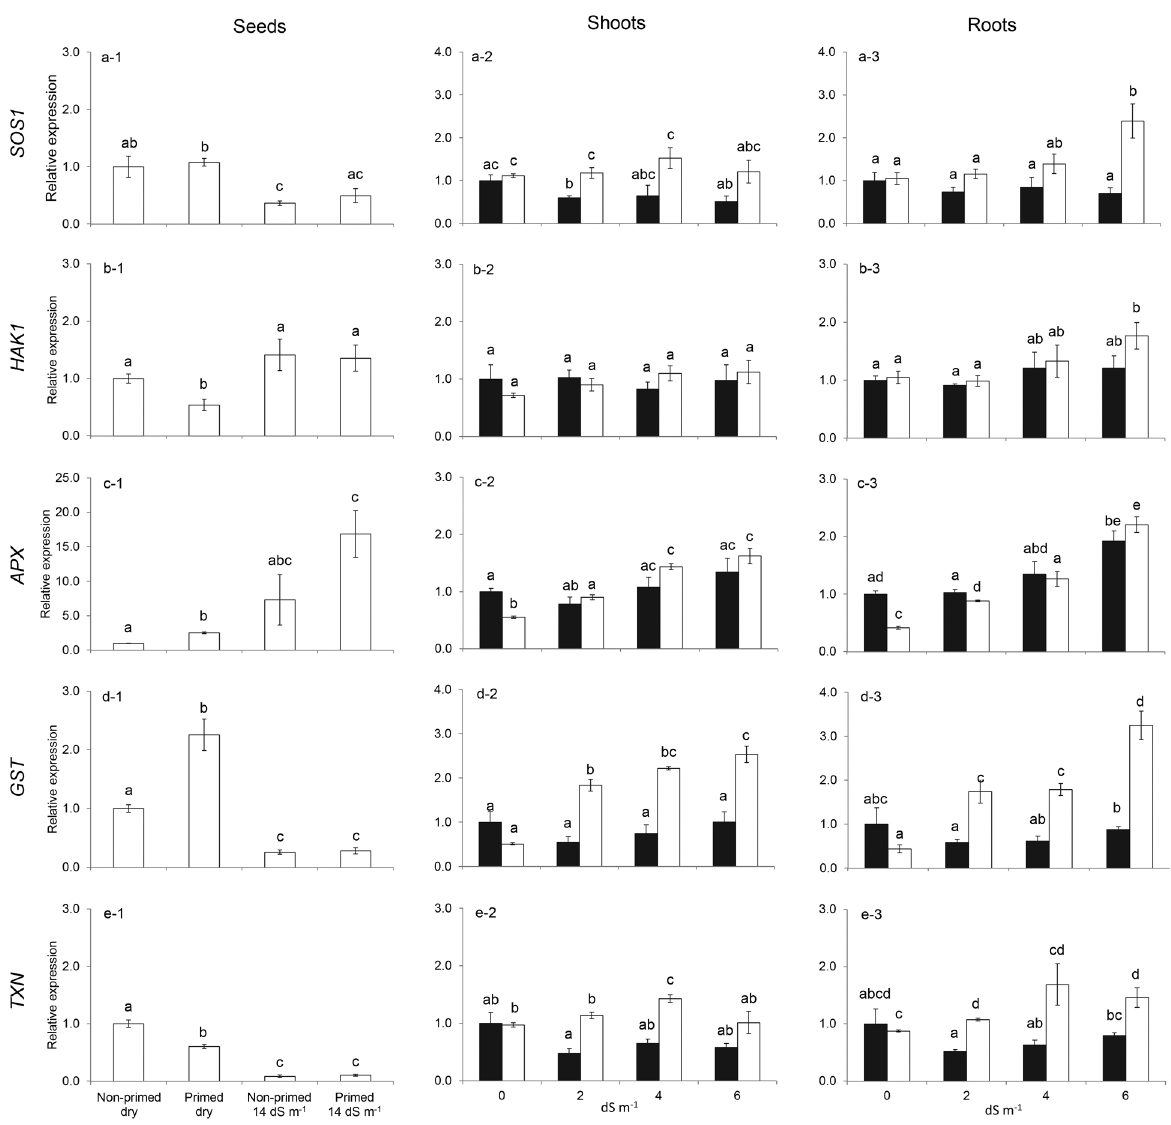
Figure 3 - Relative expression of SOS1 ( a ), HAK1 ( b ), APX ( c ), GST ( d ) and TXN ( e ) in non-primed and primed seeds, and in shoots and roots of seedlings derived from non-primed and primed seeds submitted to saline stress. (1) relative expression of the respective genes in non-primed and primed dry seeds and in non-primed and primed seeds subjected to saline stress for 10 days in 14 dS m -1 salt solution; (2), (3) relative expression of the respective genes in shoots (2) and roots (3) of seedling derived from non- primed (black bars) and primed seeds (white bars) that were grown under saline stress from zero (water) up to 6 dS m -1 salt solution. Salt concentrations expressed as salt electric conductivity (dS m -1 ). Error bars indicate ± SE of 3 biological replicates. Lower-case letters indicate signi fi cant differences (Student t-test at P <